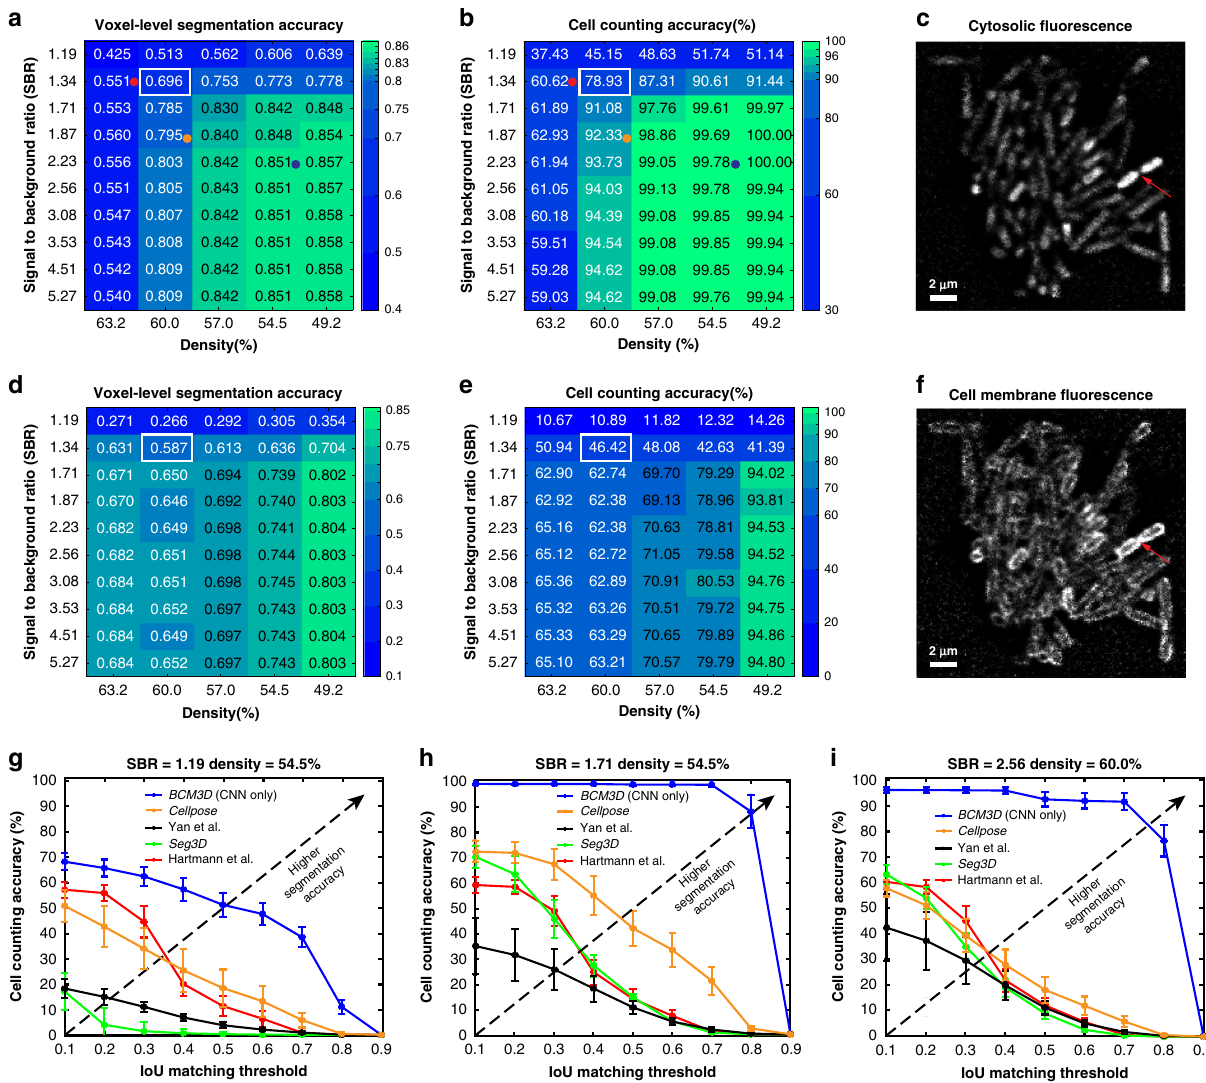
Fig. 2 Performance of BCM3D using in silico-trained CNNs only on previously unseen simulated bio fi lm images. a The voxel-level segmentation accuracy quanti fi es whether each voxel has been assigned to the correct class ( “ cell interior ” , “ cell boundary ” , or “ background ” ). Solid circles represent the maximum local density and average SBRs encountered in experimental datasets (red, orange, and blue: E. coli expressing GFP). b The cell counting accuracy (using an IoU matching threshold of 0.5 for each segmented object, see “ Methods ” section) averaged over N = 10 replicate datasets for cells labeled with cytosolic fl uorophores. c Example image of cells labeled with cytosolic fl uorophores (cell density = 60.0%, SBR = 1.34, indicated by white rectangle in a and b . Similar images were generated N = 10 times with different cell arrangements). d Voxel-level segmentation accuracy and e cell counting accuracy averaged over N = 10 replicate datasets for cells labeled with membrane-localized fl uorophores. f Example image of cells labeled with membrane-localized fl uorophores (cell density = 60.0%, SBR = 1.34, indicated by white rectangles in d and e . Similar images were generated N = 10 times with different cell arrangements). The red arrows indicate a close cell-to-cell contact point. g – i Comparison of segmentation accuracies achieved by conventional segmentation approaches (Hartmann et al., Seg3D, Yan et al.), Cellpose, and BCM3D (only using in silico-trained CNNs). Three simulated datasets (cytosolic fl uorophores) with different SBRs and cell densities are shown. Segmentation accuracy is parameterized in terms of cell counting accuracy ( y -axis) and IoU matching threshold ( x -axis, a measure of cell shape estimation accuracy). Each data point is the average of N = 10 independent bio fi lm images. Data are presented as mean values ± one standard deviation indicated by error bars. Curves approaching the upper right-hand corner indicate higher overall segmentation accuracy, as indicated by the dashed arrows. Source data are provided as a Source data fi le for Fig. 2g, h,